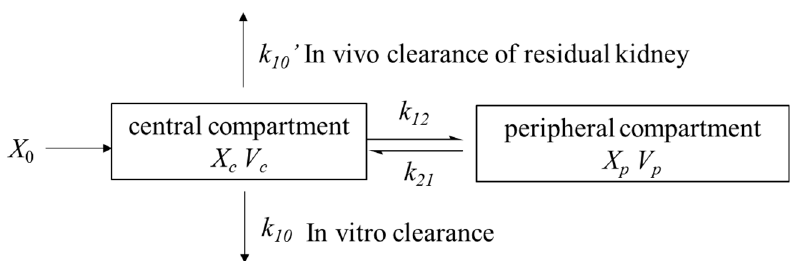
Figure 1. Two compartment model of vancomycin for critically ill patients undergoing CVVH.